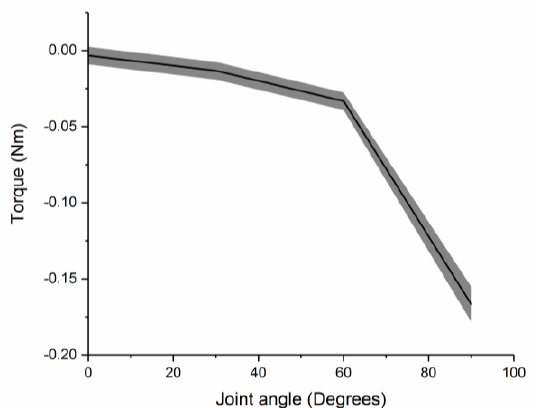
Figure 8. Measurement of resistive torque generated by SNG assembly (one FRA module and two IB modules).